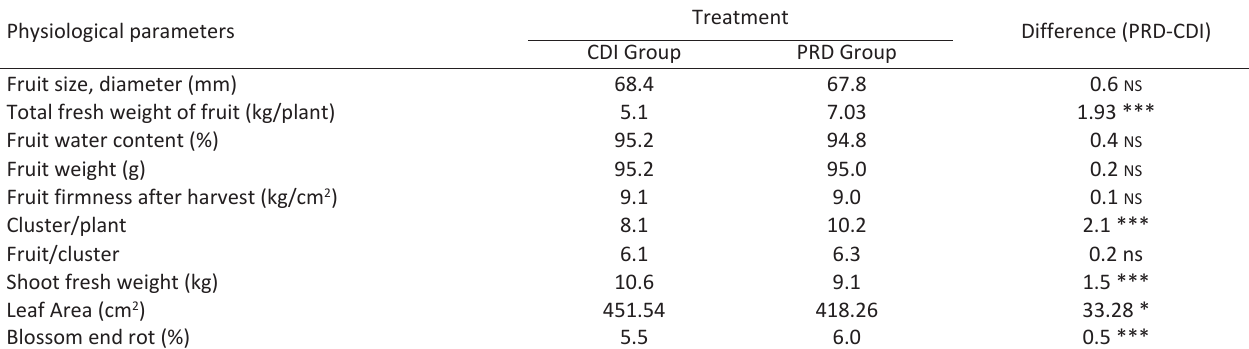
NS, *, **, *** Non-significant or significant at t≤0.05, 0.01 or 0.001